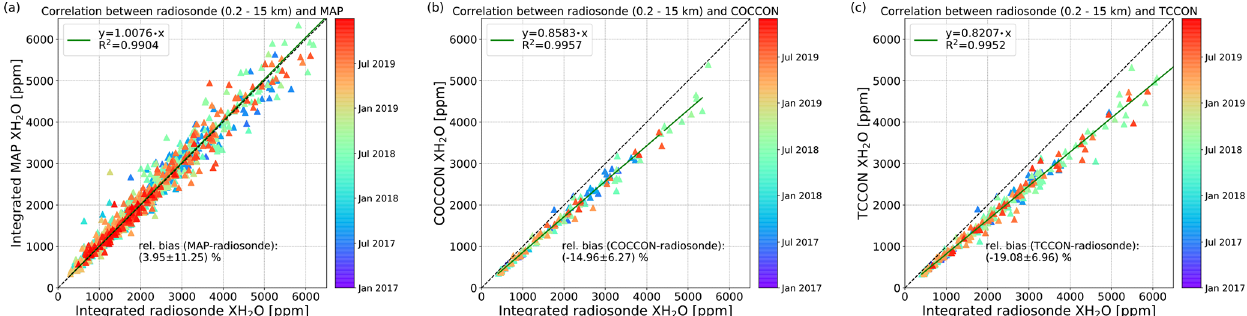
Figure 9. Correlation plots of the XH 2 O derived from (a) MAP VMR profiles, (b) COCCON, and (c) TCCON with respect to the XH 2 O derived from coincident radiosonde profiles between 0.2 and 15km at the Sodankylä site. The annotations follow those in Fig. 2.